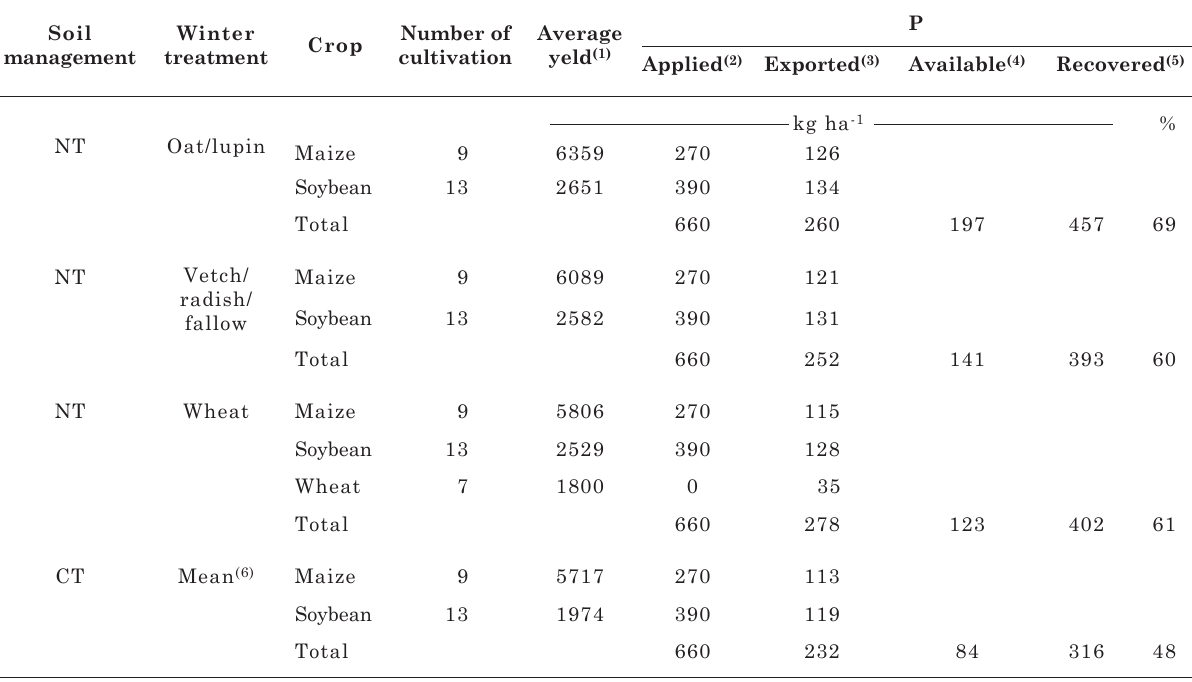
table 5. Phosphorus balance after 23 years of different soil management and winter crops of a rhodic